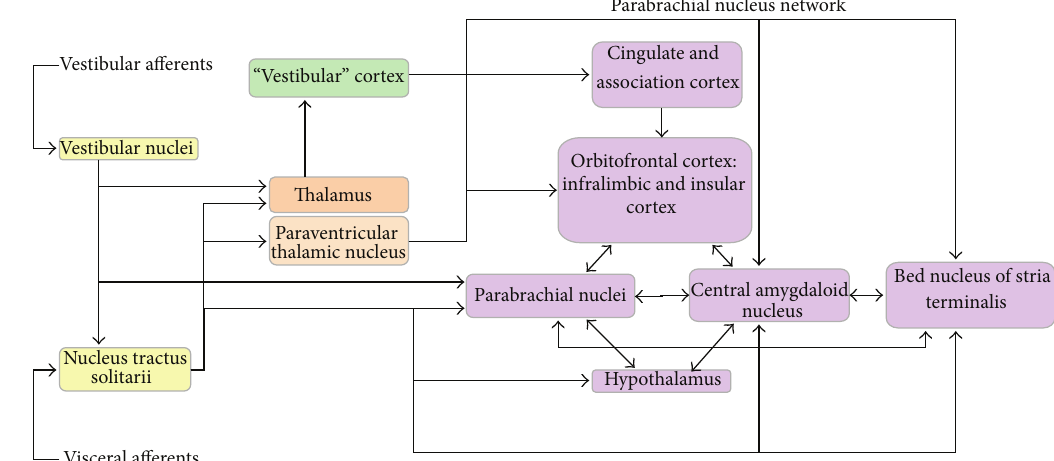
Figure 1: Neural balance-anxiety